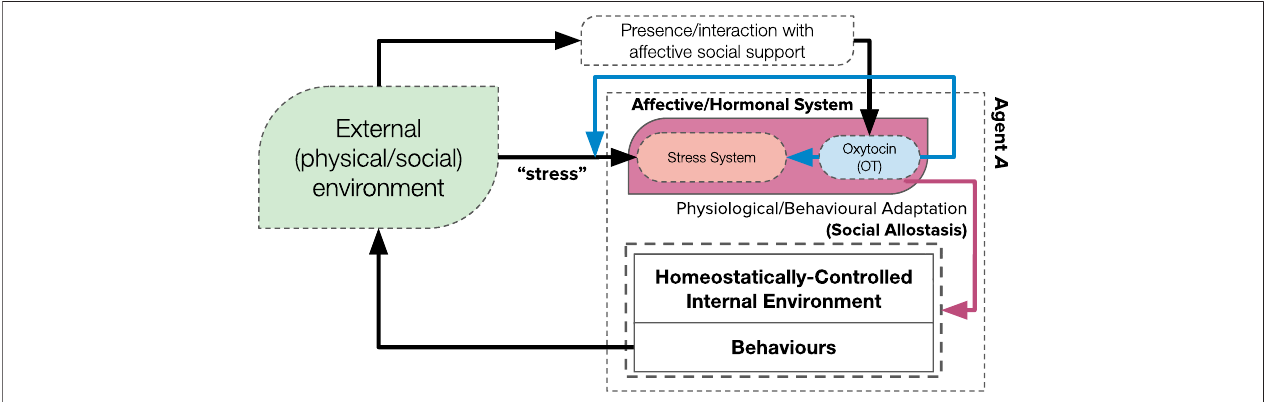
FIGURE 1 | A theoretical framework for how the hypothesised mechanisms of “ social buffering ” that we investigate in this paper (blue and red lines) underpins a mechanism of “ social allostasis, ” via an intermediary hormonal system. Perceived stressful environments result in activation of an internal stress system (McEwen et al., 2015): positive interactions with affective social support releases oxytocin, which has numerous stress-regulatory effects ( “ social buffering ” (Kikusui et al., 2006)). This affective hormonal system then adapts the internal homeostatic mechanism via physiological and behavioural adaptation.